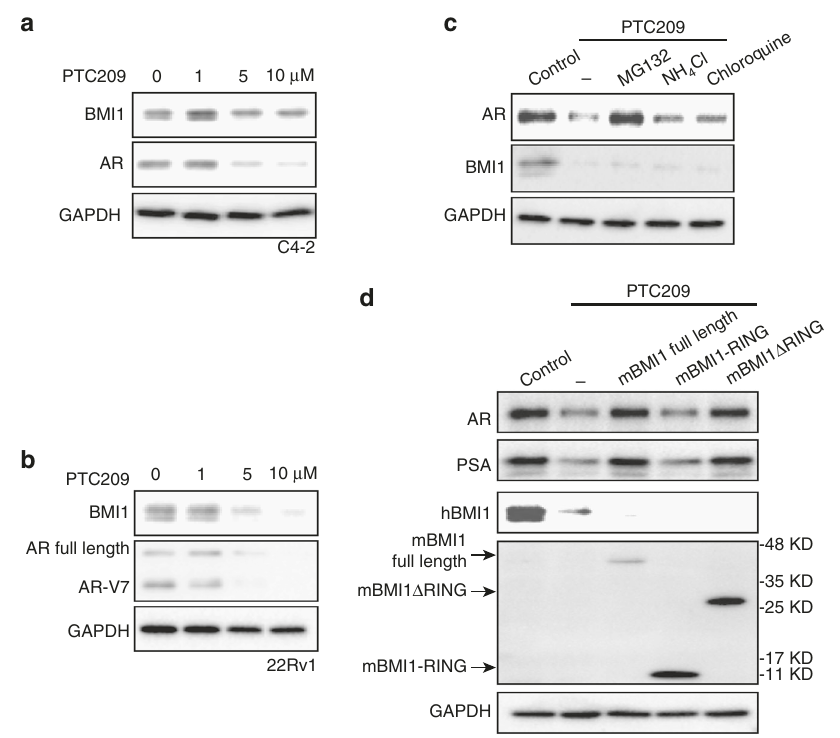
Fig. 5 BMI1-speci fi c antagonist inhibits AR-signaling pathway. C4-2 ( a ) or 22Rv1 ( b ) was treated with PTC209 in indicated concentration for 48 h, BMI1 and AR were tested by western blot, and GAPDH served as loading control. c C4-2 cells were treated for 48 h as labeled, vehicle as control, and the concentration of each drug was PTC209 5 µ M, MG132 20 µ M, NH 4 Cl 10 mM, and chloroquine 200 µ M. Total cell lysates were blotted for AR and BMI1, while GAPDH served as loading control. d C4-2 cells were treated with PTC209 (5 µ M), and after 24 h, cells were infected with BMI1 lentivirus, BMI1-RING lentivirus, or BMI1 Δ RING lentivirus as indicated in the presence of PTC209, and cells were lysed after another 24 h and probed by indicated antibodies. All experiments were biologically repeated at least three times. Representative images are